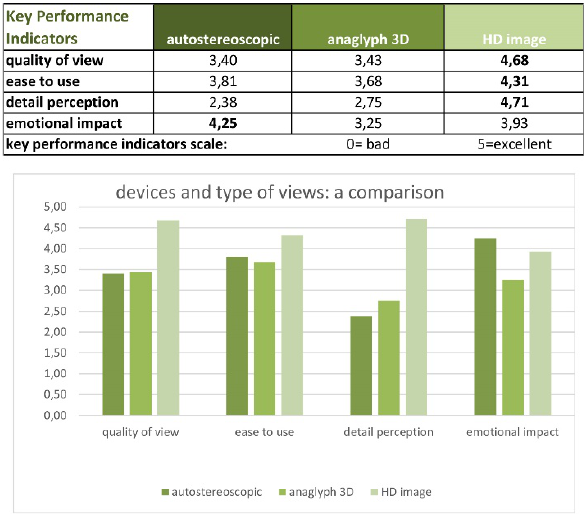
Figure 10. Test results on the usability and preferences about three kind of visualization for 3D models and HD